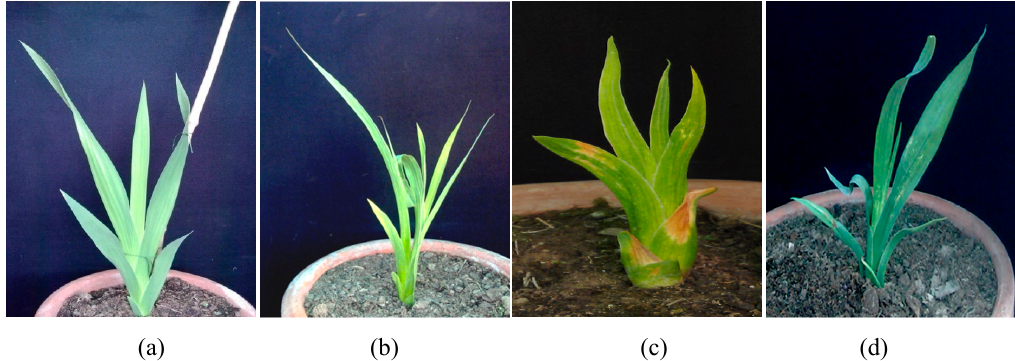
Figure 2. Production of foliar abnormalities in gladiolus cv. White Prosperity at different concentrations of colchicine: normal shaped leaves in control ( a ) but different abnormal leaves shapes observed in 0.1% ( b ), 0.2% ( c ) and 0.3% colchicine ( d ).